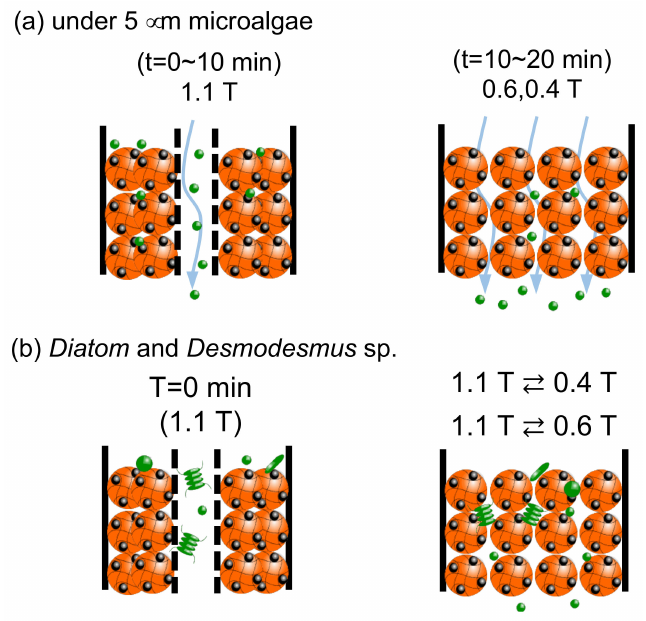
Figure 11. Illustrated image of dynamic elution of microalgae.( a ) case of microalgae under the size of 5 micrometer, and ( b ) case of Diatom and Desmodesmus